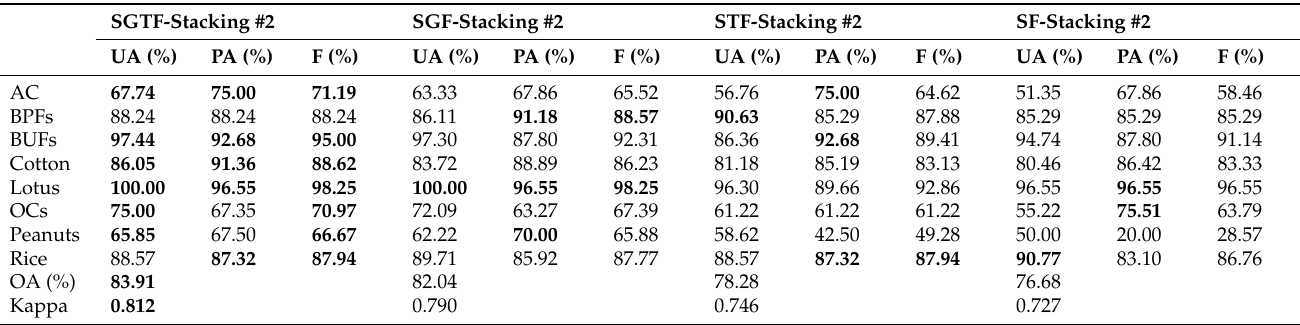
Table 7. Overall accuracies, kappa values, and classwise accuracies generated by the Stacking #2 model with different input feature